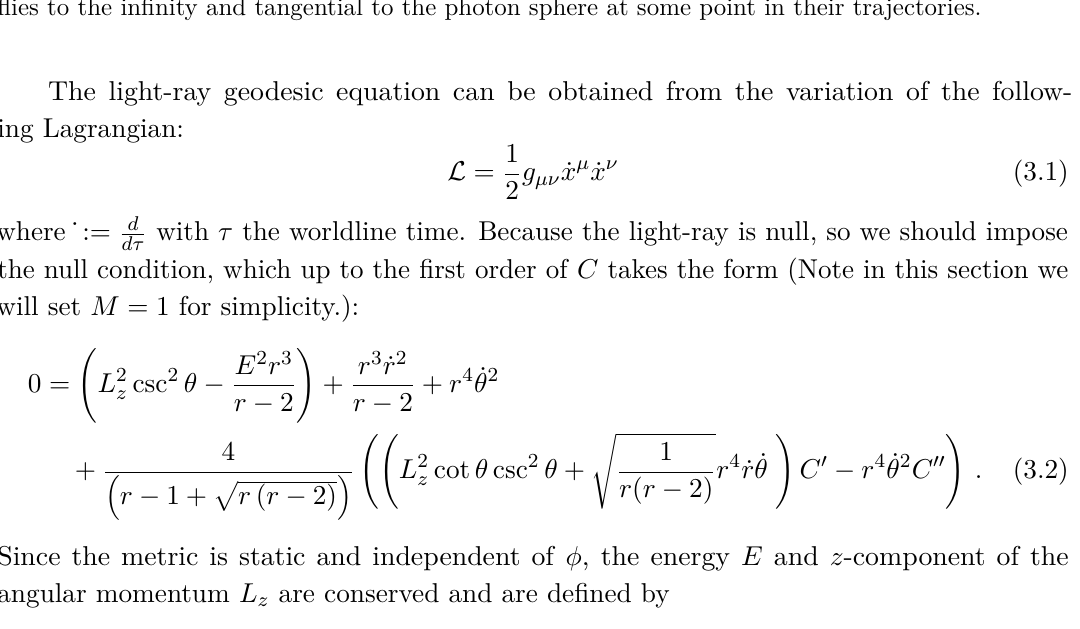
Figure 2 . Schematic picture of black hole shadow on the celestial image plane left by the light-rays marginally escaping from the black hole and ending on the observer. Light ray 2 slightly bends due to gravitational pull of the black hole and flies to the infinity. Light ray 3 falls into the black hole and never reaches the observer. Lastly, light ray 1 which corresponds to the boundary of the shadow flies to the infinity and tangential to the photon sphere at some point in their